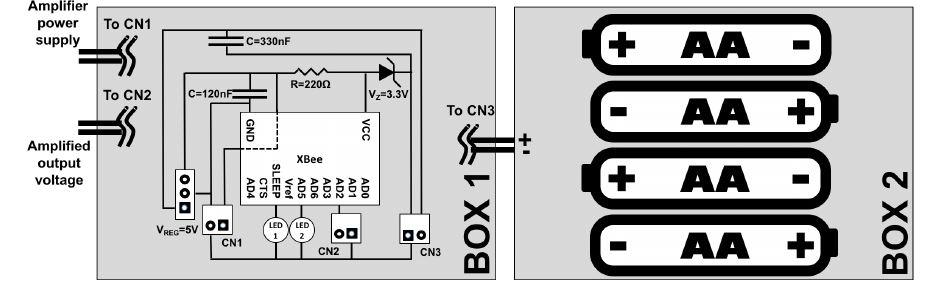
Figure 6. Scheme of the two boxes with the electric diagram of the data acquisition and transmission module. The 2-line connectors CN1 and CN2 are used respectively to feed the amplifier, located in the bottom of the rotating part, and to bring the amplified output voltage in the AD2 input of the XBee. The 2-line connector CN3 is used to bring the supply voltage from the batteries.